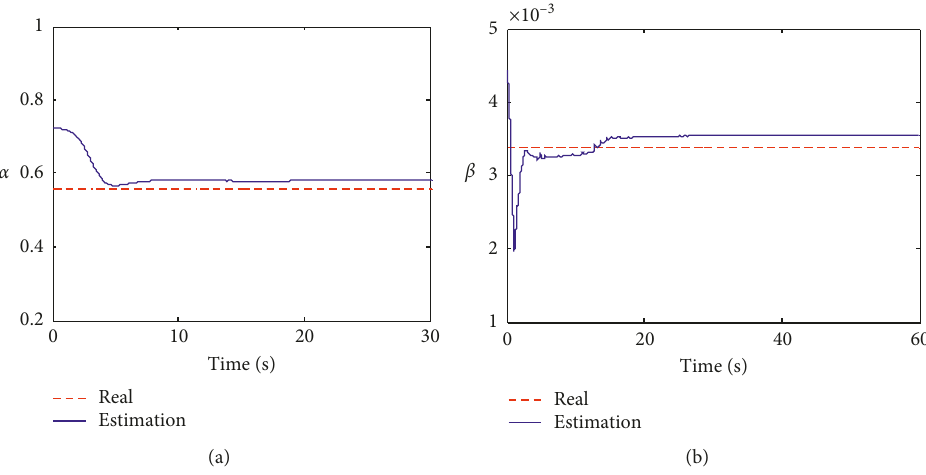
Figure 7: Estimation results of unknown damping coefficients: damping coefficients (a) α and (b) β . Table 3: Estimation values and errors of structural parameters. Structural